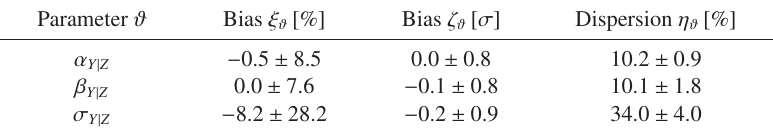
Figure 2. Distributions of the biases ( top ) and dispersions ( bottom ) of the scaling relation parameter estimators over the 5000 mock LPSZ-like samples. No significant bias is found on the parameters of interest. Relative uncertainties are on average 10% on the slope and intercept of the scaling relation, ⇠ and 34% on its intrinsic scatter. Shaded regions are 1  . ⇠ Table 1. Summary of the biases and dispersions on each parameter of interest in our scaling relation analysis. Values reported are the mean values and 1